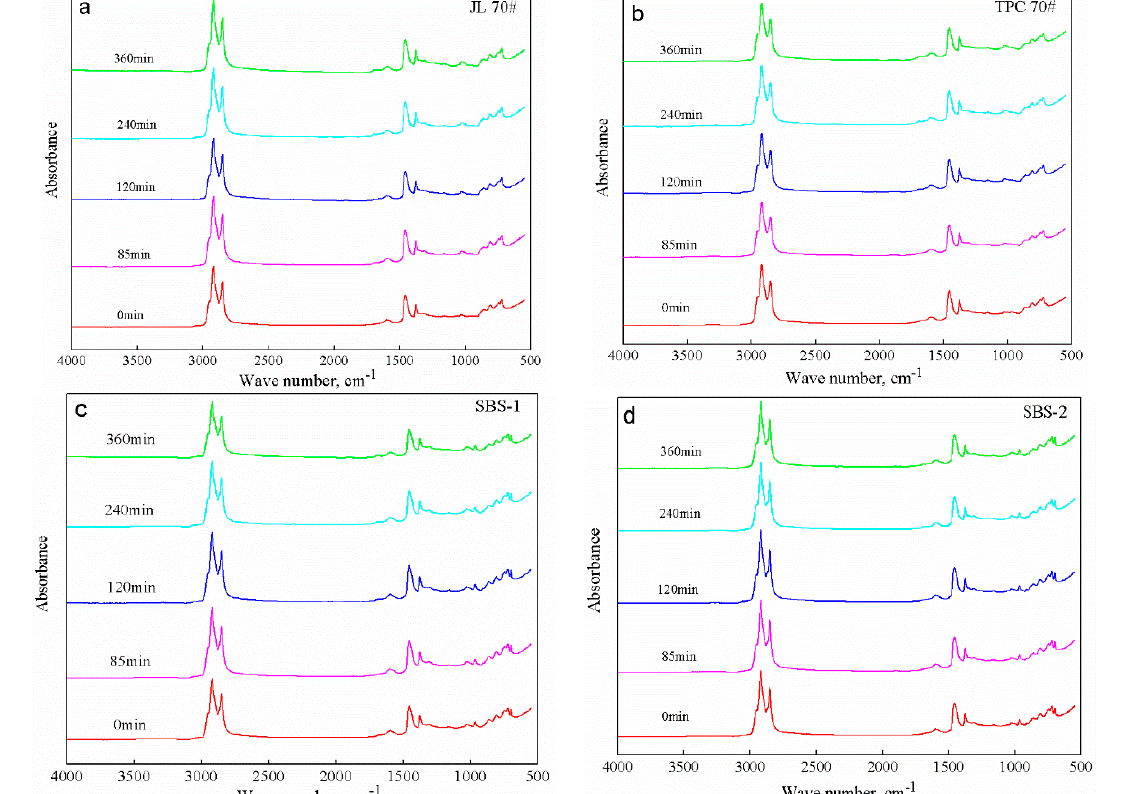
Figure 4. The infrared spectrum diagrams of four types of asphalt with different aging time. ( a ) JL70#; ( b ) TPC70#; ( c ) SBS-1; ( d ) SBS-2.